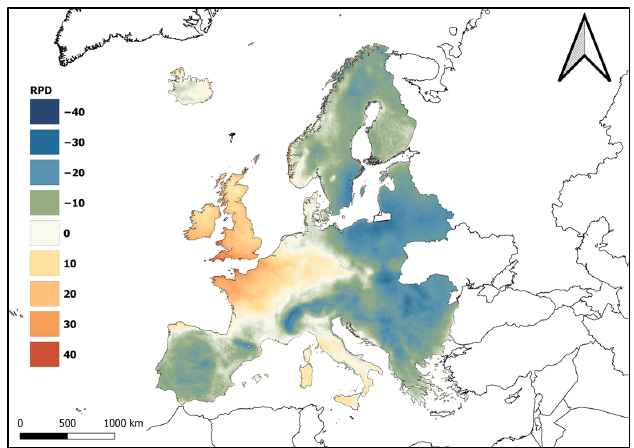
Figure 6. Relative percentage difference of PM 2.5 for the lock down period of the year 2020 with the average of the previous 4 months and the following 4 months.